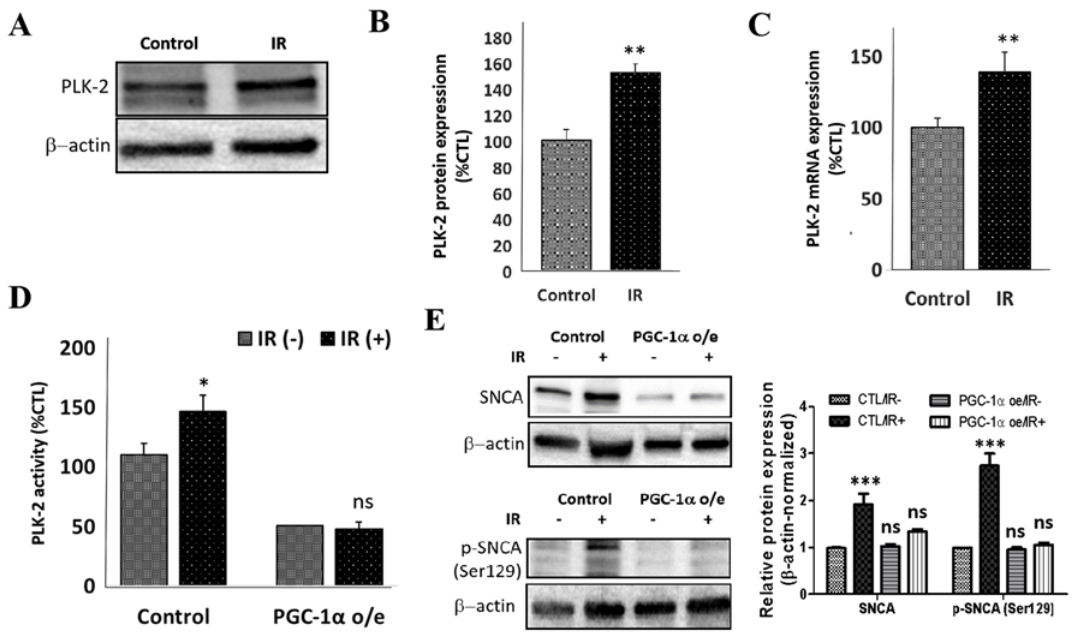
Figure 6. PGC-1 α overexpression represses IR-enhanced PLK2 activity and subsequent increase in Figure 6. PGC ‐ 1 α overexpression represses IR ‐ enhanced PLK2 activity and subsequent increase in SNCA. ( A ) Representative Western blot images and ( B ) densitometry-based graph showing the e ff ect SNCA. ( A ) Representative Western blot images and ( B ) densitometry ‐ based graph showing the effect of IR on the expression of PLK2 protein in SH-SY5Y cells (control: 100.5 ± 8.4%, IR: 152.9 ± of IR on the expression of PLK2 protein in SH ‐ SY5Y cells (control: 100.5 ± 8.4%, IR: 152.9 ± 6.9%, p <